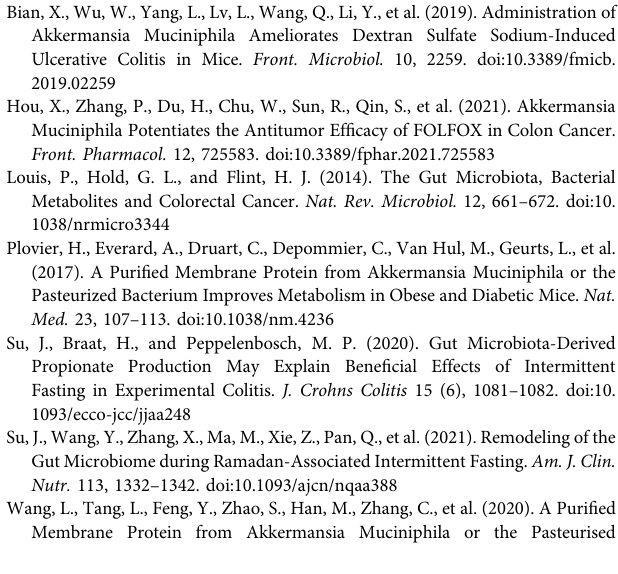
FIGURE1| dynamicsofmeanabundanceofthebacteriumfrommiddle-agedunfastedvolunteers.Fecalsampleswerecollectedatthesametimepointasin Figure1B ( n = 10). * p < 0.05 by Wilcoxon-singed rank test. (D) Change in A. municiphila at day 15 (left) or day 30 (right) was calculated for each individual in the young cohort by subtracting the relative abundance observed before fasting from that of during or after fasting. As a result, 83.3 percent (25/30) of volunteers displayed upregulated bacteriumabundanceatday15and43.3percentatday30. (E) Changein A.municiphila atday30(left)orday60(right)foreachindividualinthemiddle-agedcohortwas calculated as above. The bacterium was upregulated in 74.1 percent of volunteers (20/27) at day 30 and 60.9 percent (14/23) at day 60. (F) Change in A. municiphila at